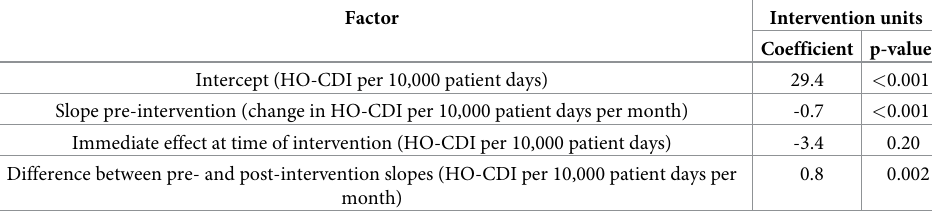
Table 3. Time series analysis hospital onset- Clostridioides difficile